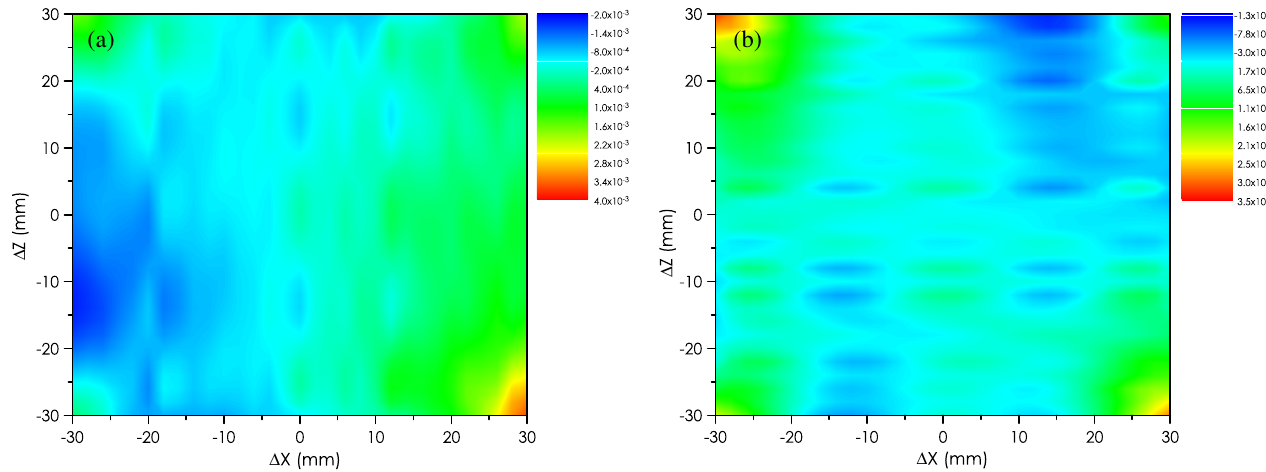
FIG. 11. Uniformity of the (a) horizontal GL, (cid:1) G x L=G x L , and (b) vertical GL, (cid:1) G z L=G z L , products along the beam trajectory, for the small-aperture magnet after